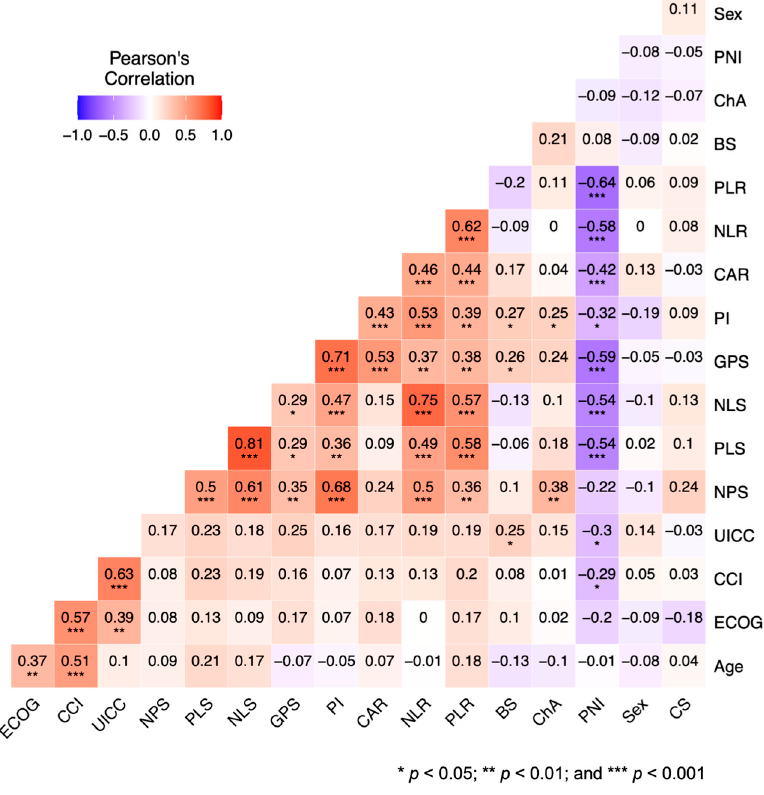
Table 4. Progression ‐ free and overall survival in the univariate analysis (Univariate cox analysis).